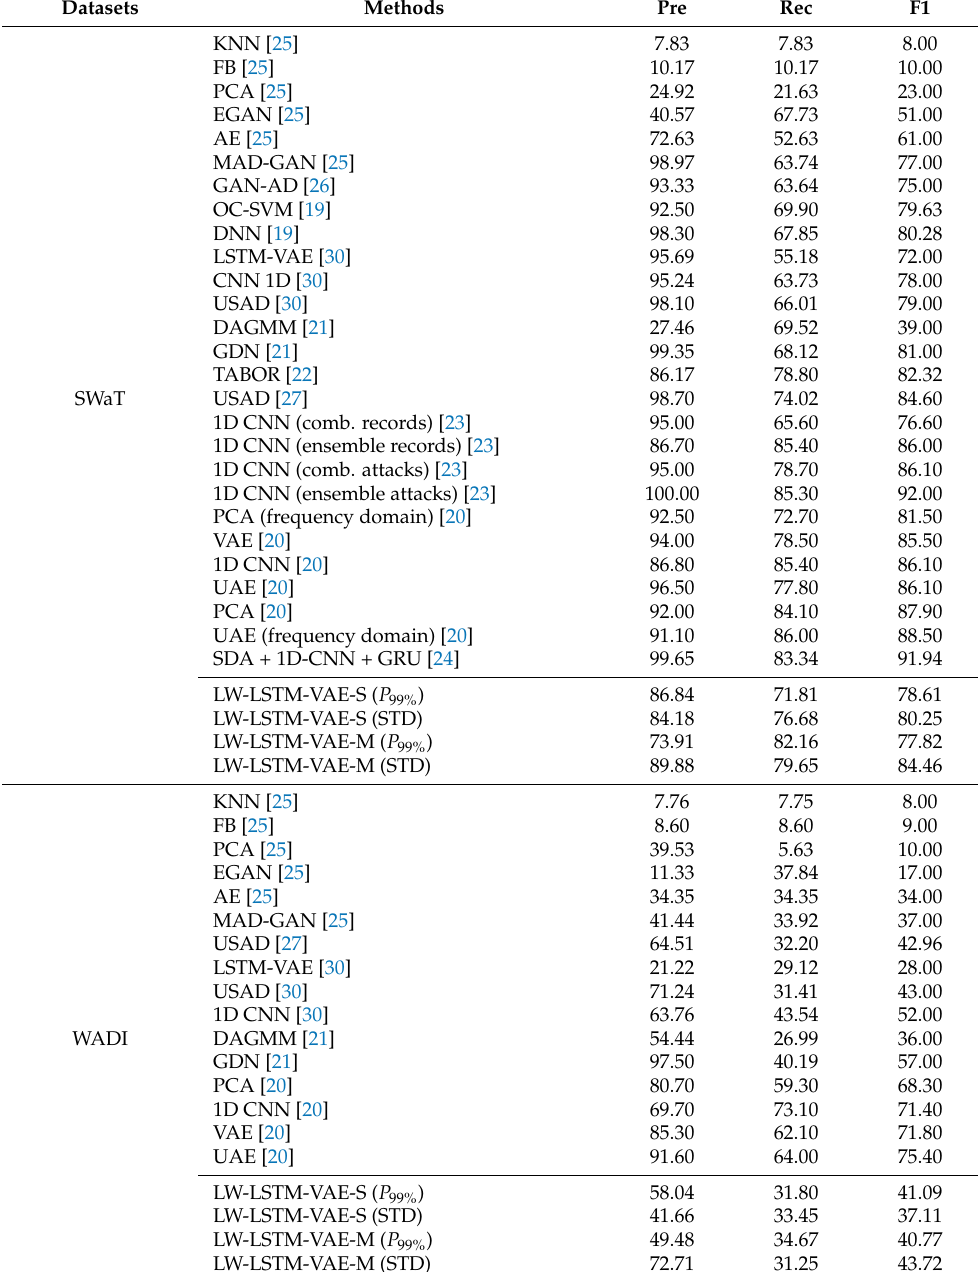
Table 7. Comparison of our solution to previous